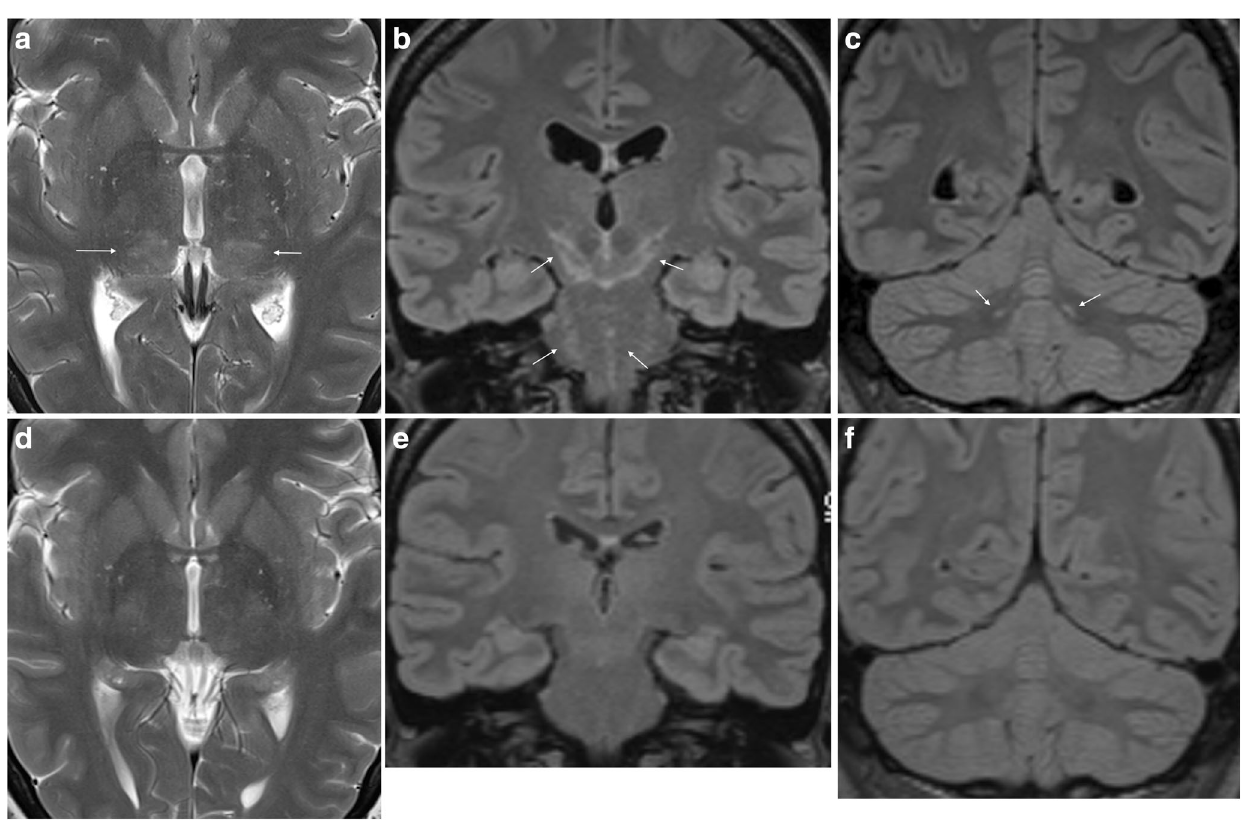
Fig. 6 LNB encephalitis in a 40-year-old woman. She presented with 1 day history of headache, vomiting, dizziness and personality change. The CSF cell count was 182 cells/mm 3 . MRI showed symmetric diffuse and patchy T2 ( a ) and FLAIR ( b , c ) hyperintensity of inferior thalami (arrows in a ), cerebral peduncles, mesencephalon, pons (arrows in b ) and cerebellar dentate nuclei (arrows in c ). There were no abnormalities on